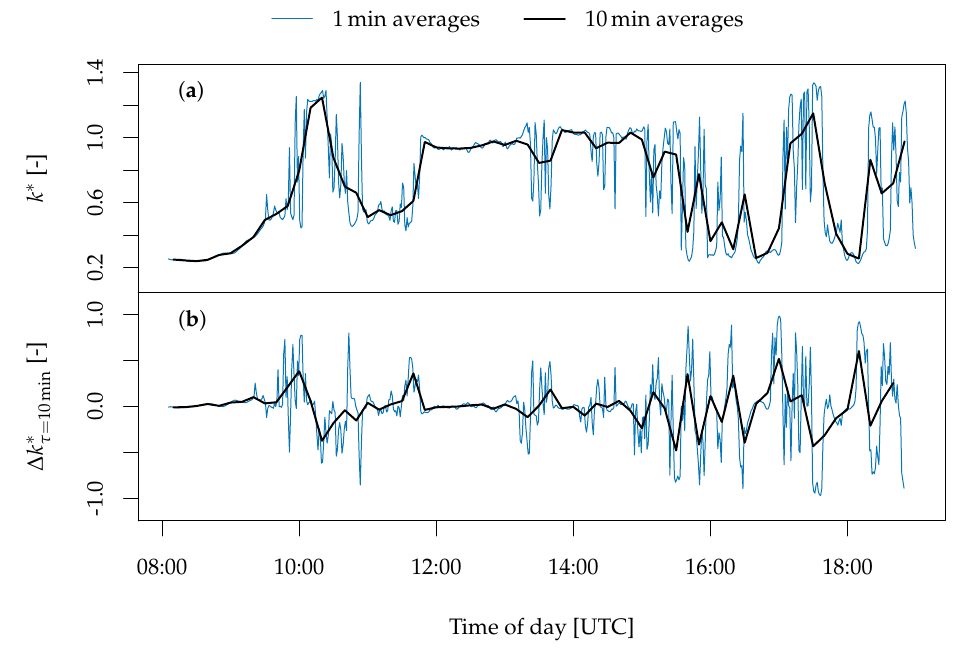
Figure 8. An example of temporal averaging: ( a ) Averages of 1min and 10min temporal resolutions based on the 1s single-sensor clear-sky index k ∗ time series shown in Figure 1 (collected during the HOPE campaign [138,139]); ( b ) Corresponding 10min clear-sky index increments ∆ k ∗ τ derived according to Equation